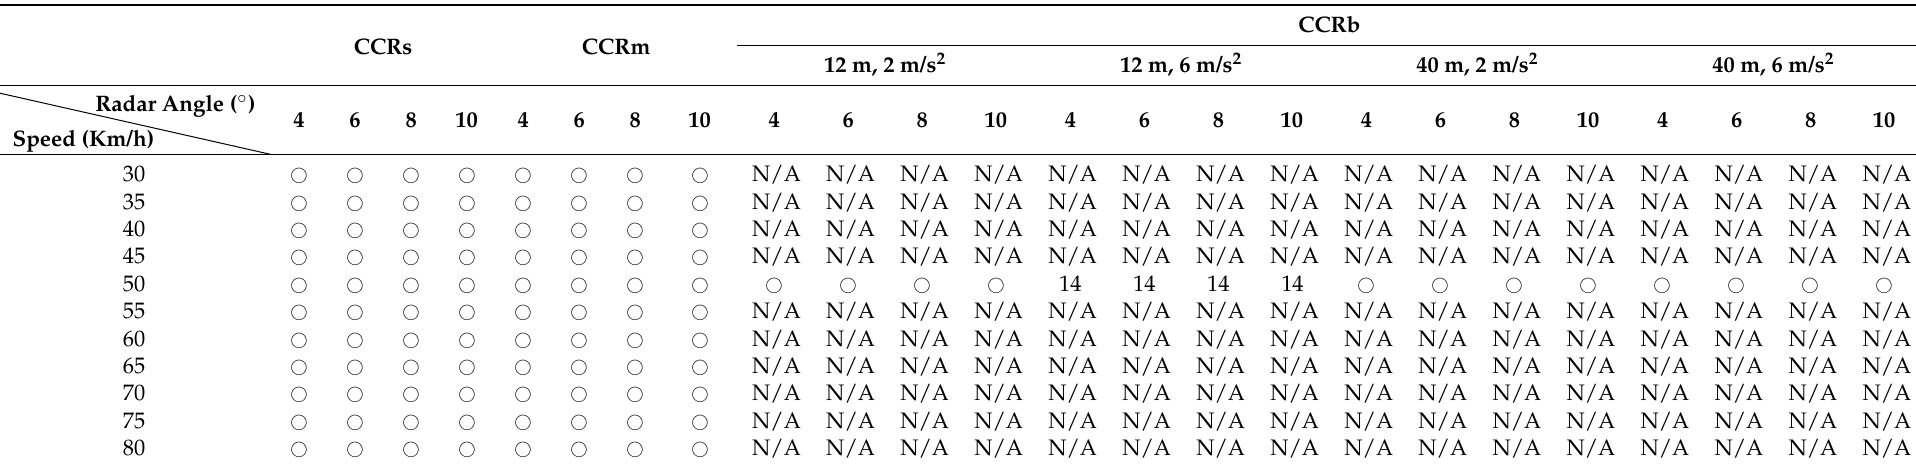
Table 3. AEBS scenario inter-urban results.